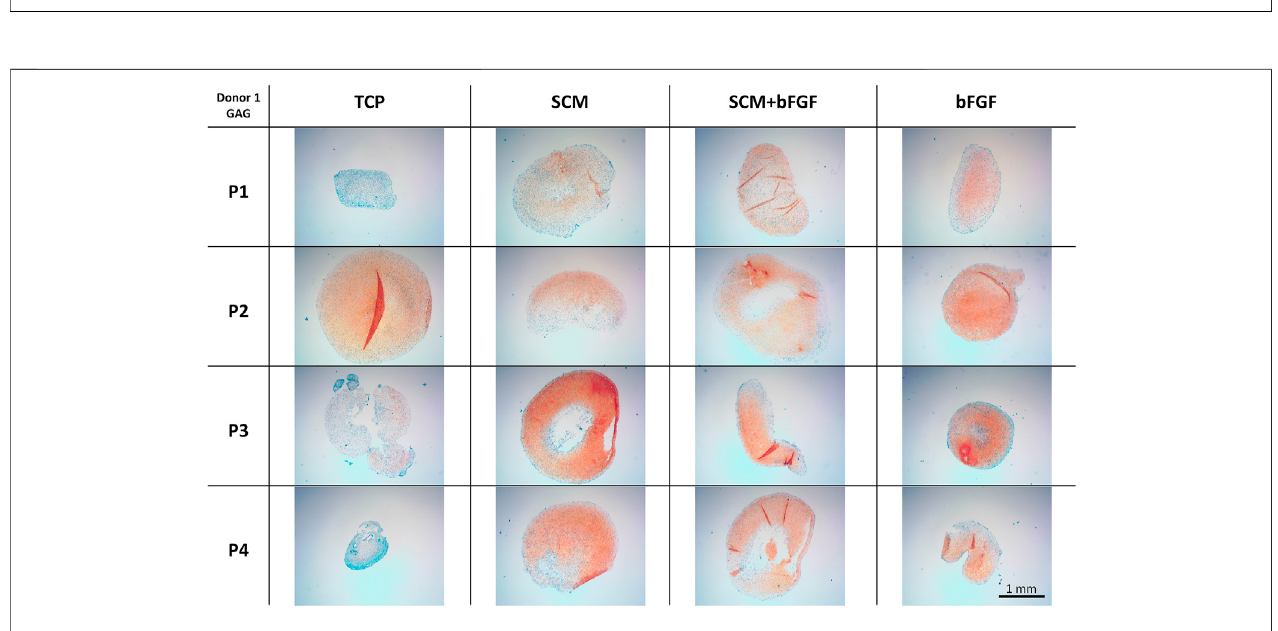
FIGURE 7 | Cartilage aggregate images showing glycosaminoglycan (GAG) staining. Sections of cartilage aggregates from a single donor over the four passages on each surface are shown here stained with safranin-O/Fast Green. All at the same scale, scale bar 1 mm. See Supplementary Figures S2 – S4 for other donors.